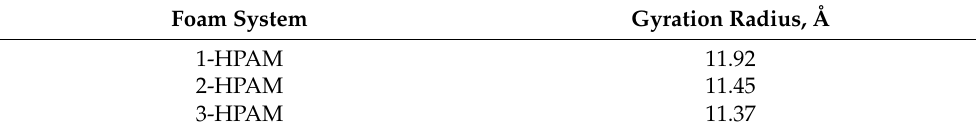
Table 6. Gyration radius of HPAM molecules in foam systems with different HPAM concentrations. Foam